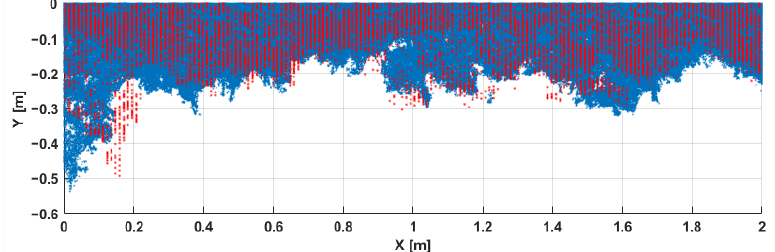
Figure 8. Comparison of point clouds from terrestrial lidar (red) and UAS photogrammetry (blue) in a top view (right side of the canopy).